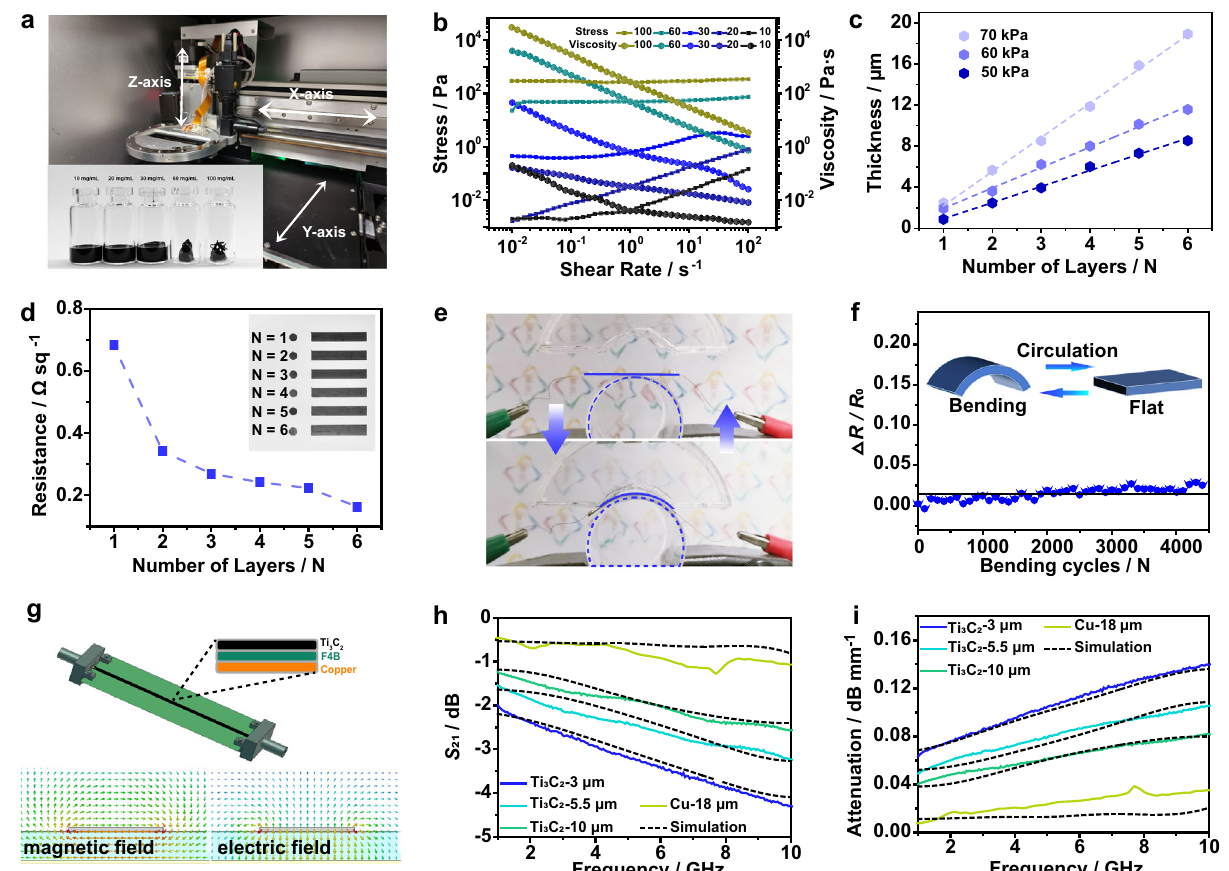
Fig. 3 | Extrusion printing for Ti 3 C 2 microstrip TLs. a The internal structure of a microelectronic printer. Inset: Photographs of various Ti 3 C 2 inks. b Stress and viscosity plotted as a function of shear rate. c Thickness plotted as a function of layer number. d Sheet resistance plotted as a function of layer number. Inset: Optical images of various printed lines (3cm in length, 50kPa) with different layer